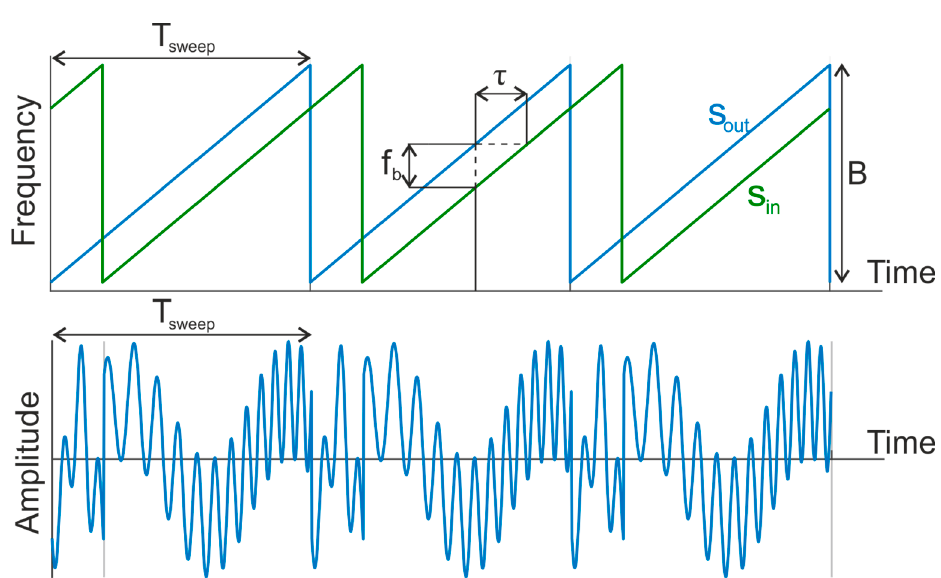
Figure 6. The ( top ) graph shows the linear frequency sweep of the frequency-modulated continuous-wave (FMCW) output signal S out (blue) and reflected input signal S in (green). The reflected signal is delayed by a time τ (time-of-flight) resulting in a frequency difference of f b at the receiver. The ( bottom ) graph shows the time-dependent amplitude of the mixed input and output signal. It consist of the two beat frequencies (sum and difference frequency) of input and output signal. In the given measurement scheme, only the difference frequency is